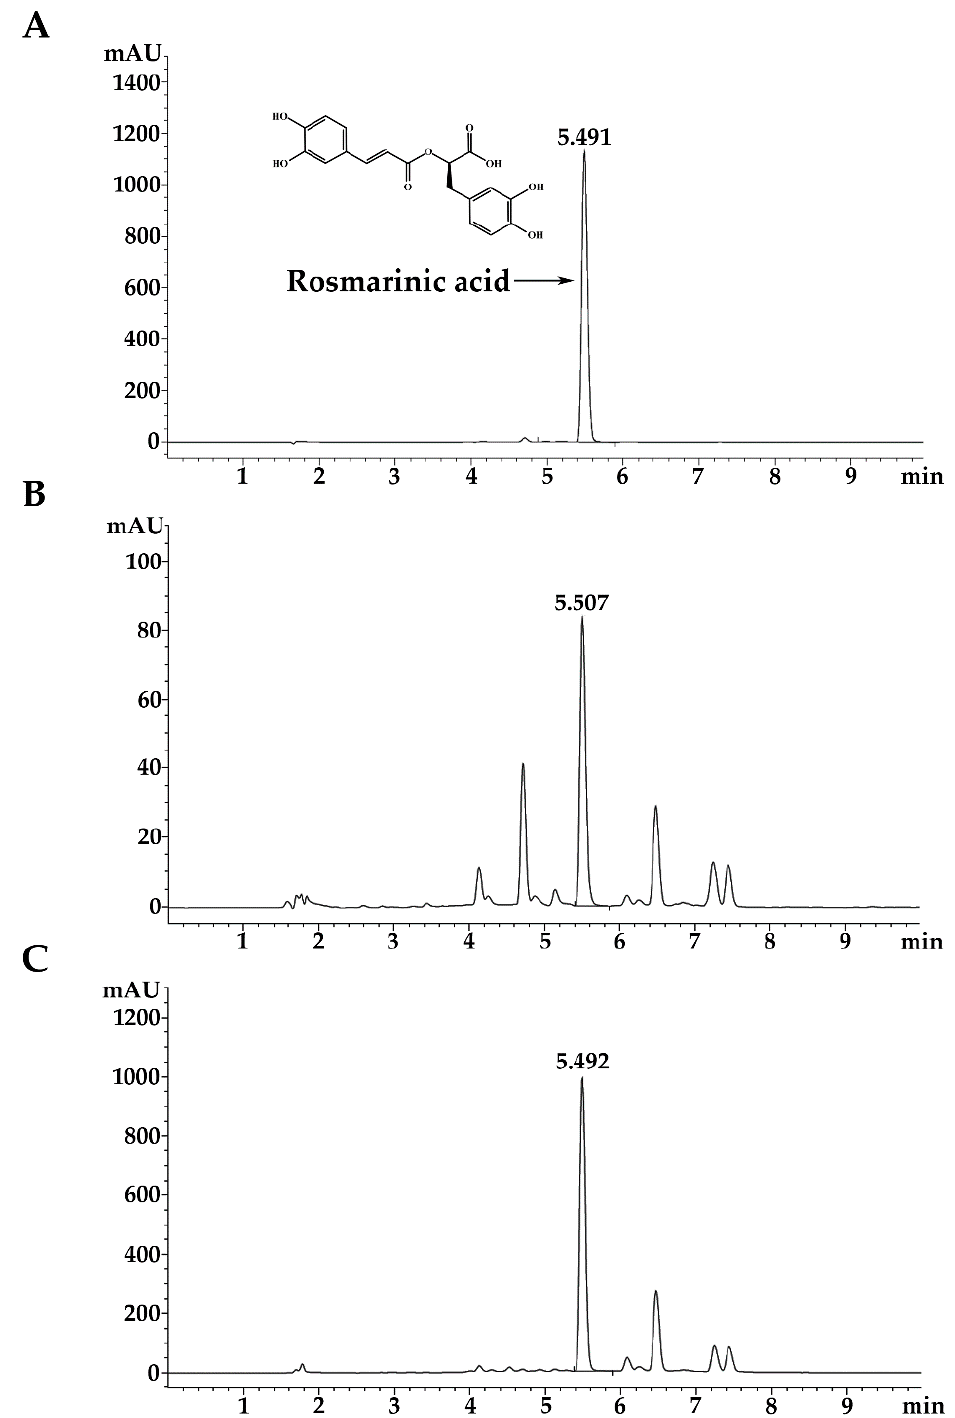
Figure 1. Ultra-high-pressure liquid chromatogram of PSM extract fractions: RA standard ( A ), EtOH ( B ) and EA ( C ).